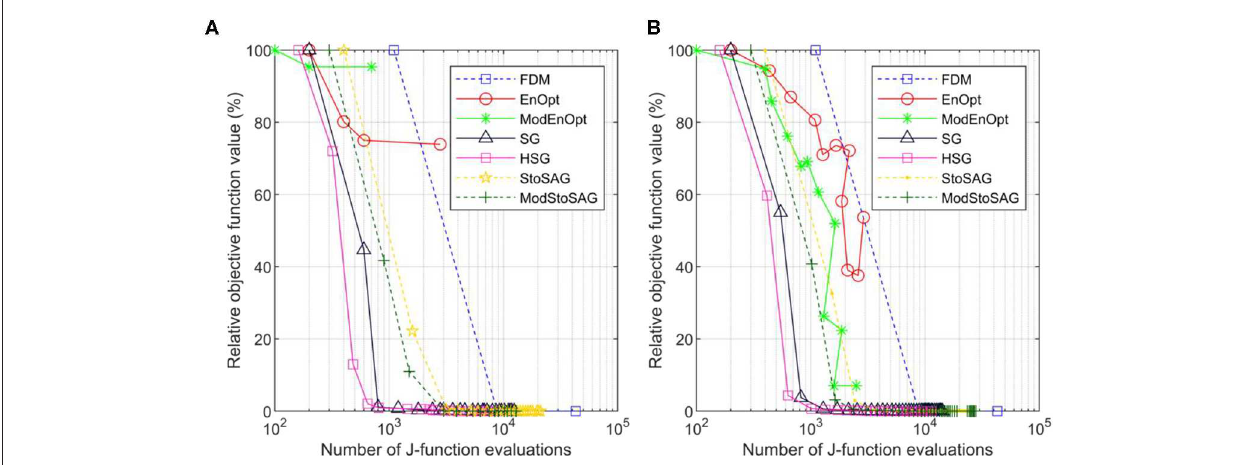
FIGURE 2 | Plot of numbers of J -function evaluations and relative objective function values of the seven gradient methods for σ m = 1. (A) Relative objective function value is a percentage of the initial objective function value. Symbols represent iterations, and the x -axis is the total number of function evaluations. (B) Shows the average relative objective function values and the average total number of function evaluations of 100 optimization runs.